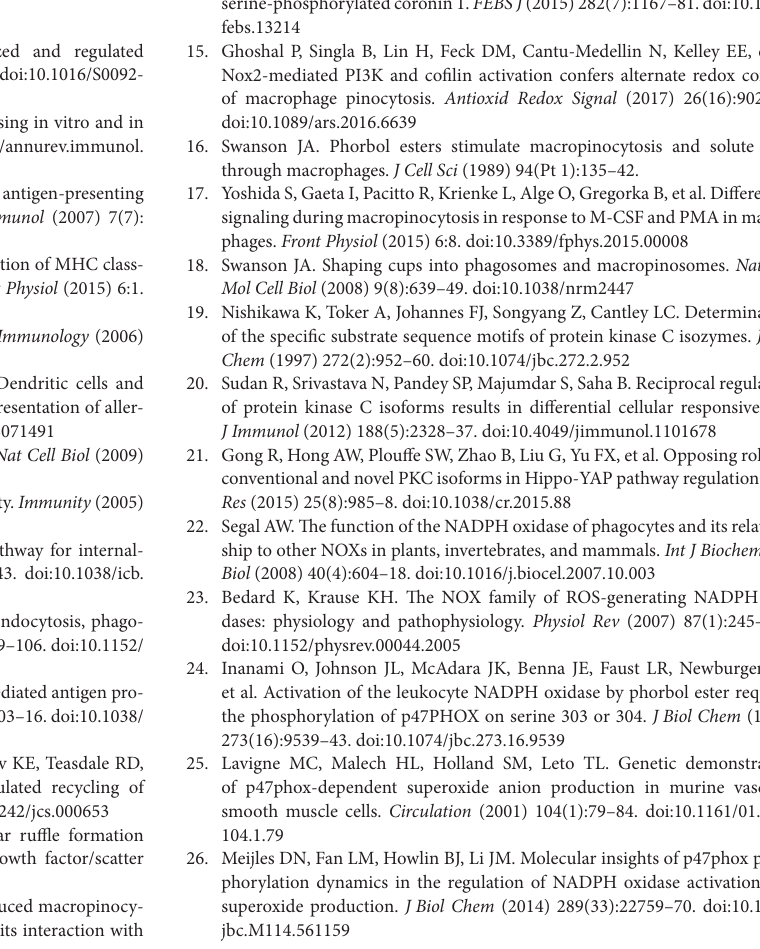
TaBle s1 | List of primers used for mRNA quantitation using